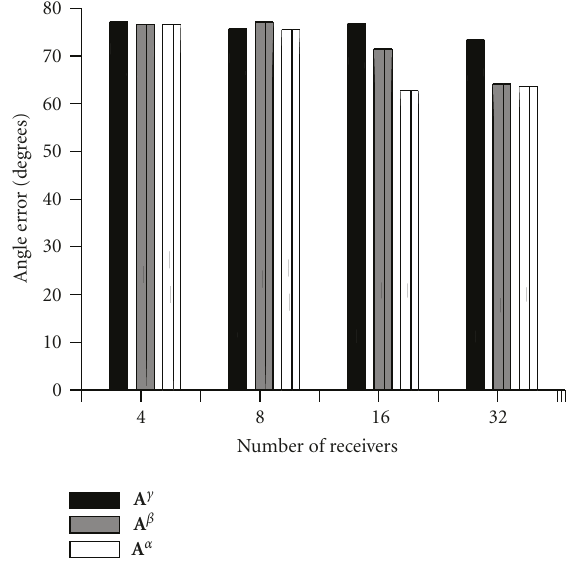
Figure 10: Direction of travel angle error for C = 0 . 95.